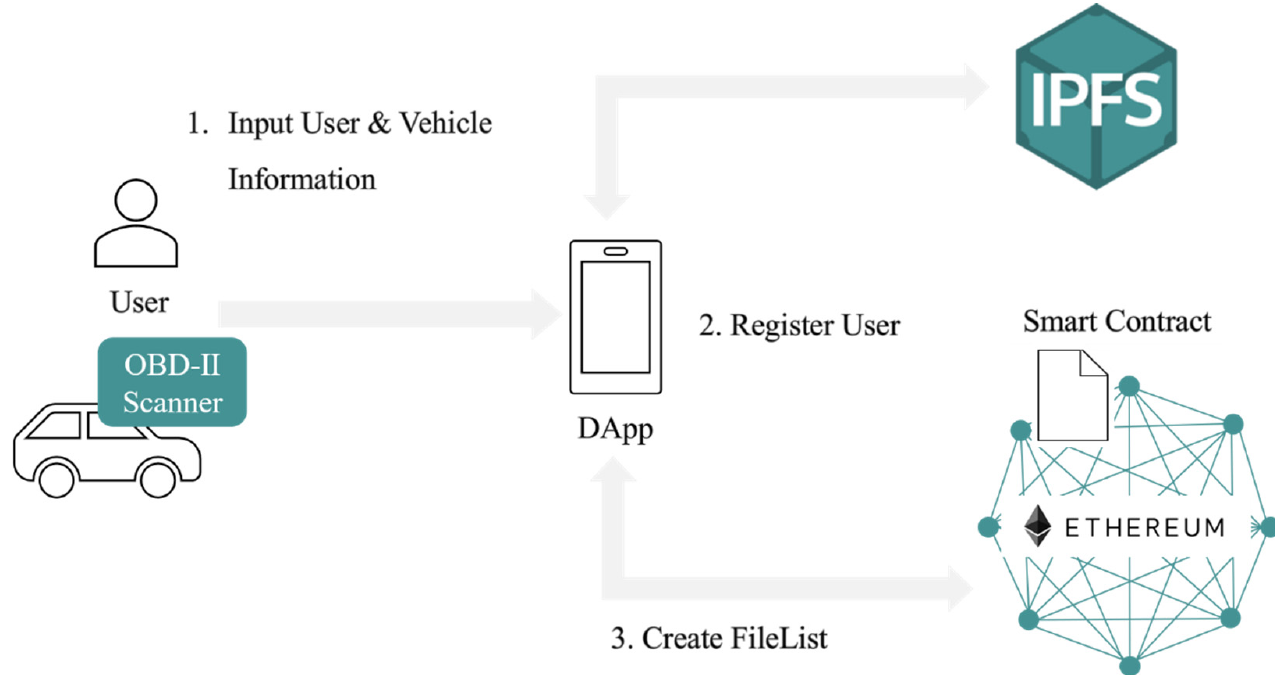
Figure 2. Process of registering vehicles and users.